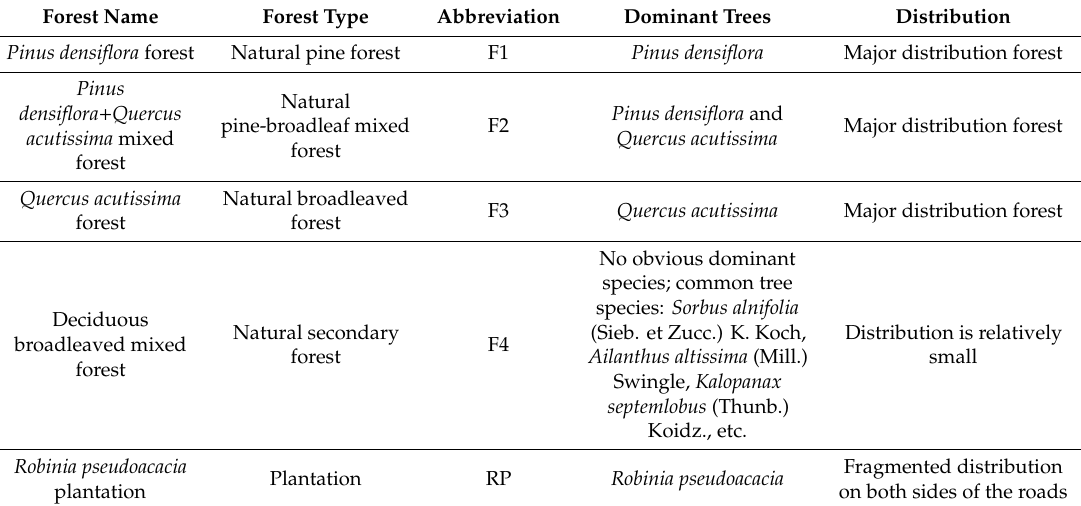
Table 1. Information on the five types of